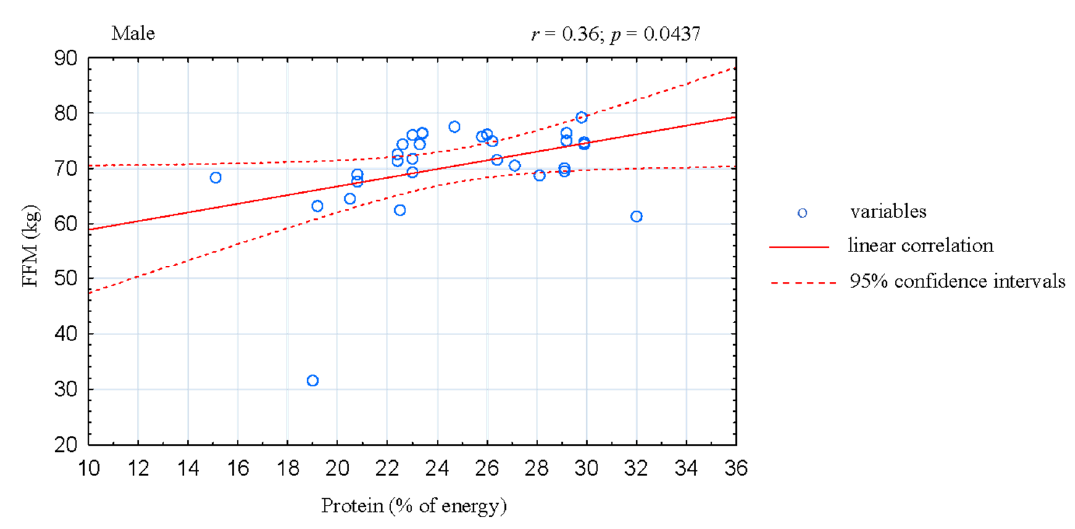
Figure 4. Correlation between dietary protein intake and FFM in male CrossFit-trained individuals.